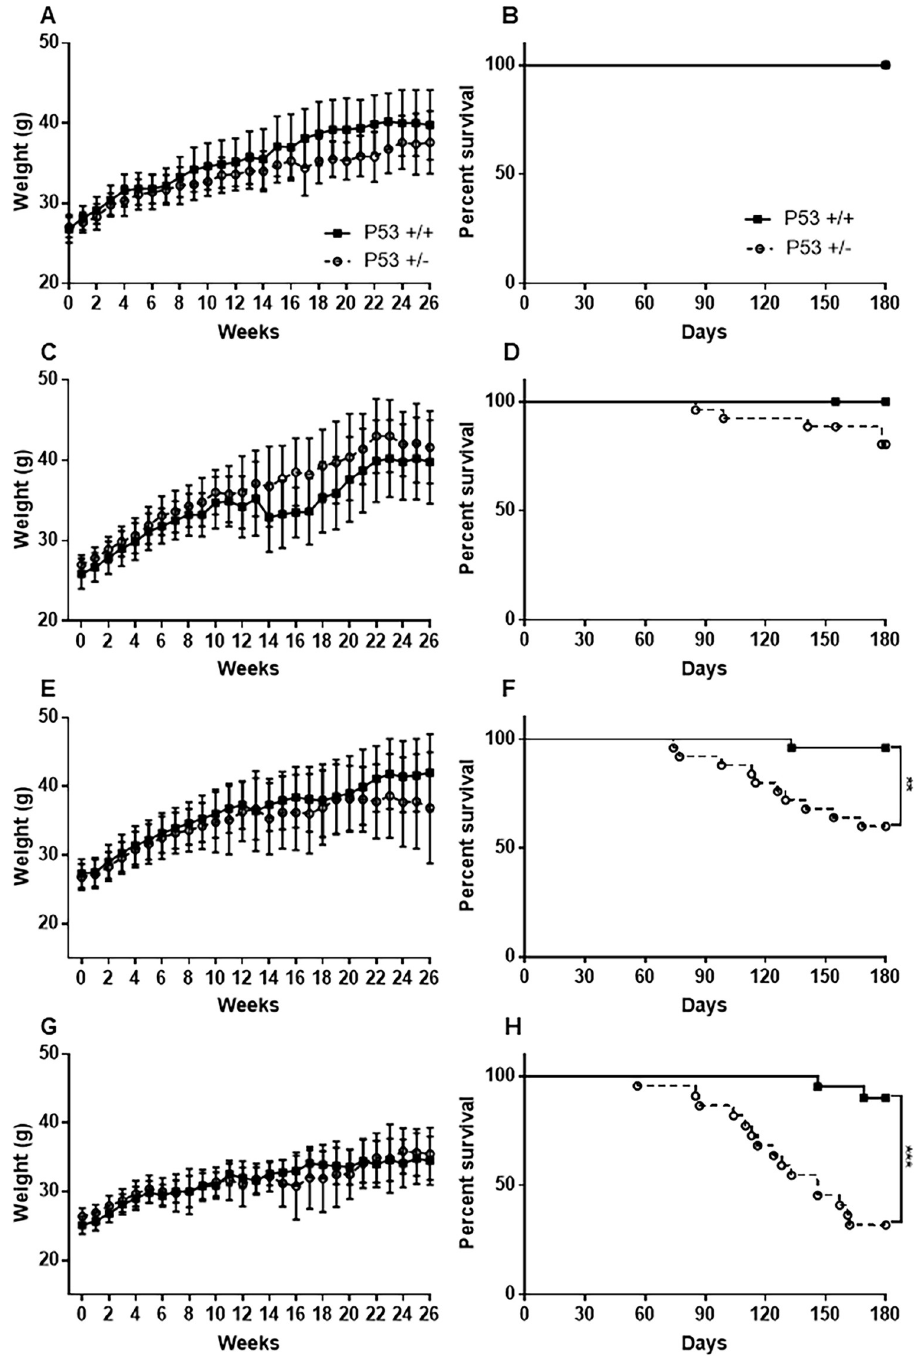
Fig 1. Body weight change and survival rate after MNU administration in different dosages. Body weight change of the 0 (untreated control; A), 25mg/kg (C), 50mg/kg (E), and 75mg/kg (G) group; survival rate of the 0 (B), 25mg/kg (D), 50mg/kg (F), and 75mg/kg (H) group. Data are represented as mean ± SD. �� P < 0.01 and ��� P < 0.001 versus wild-type mice, as assessed using Long-rank